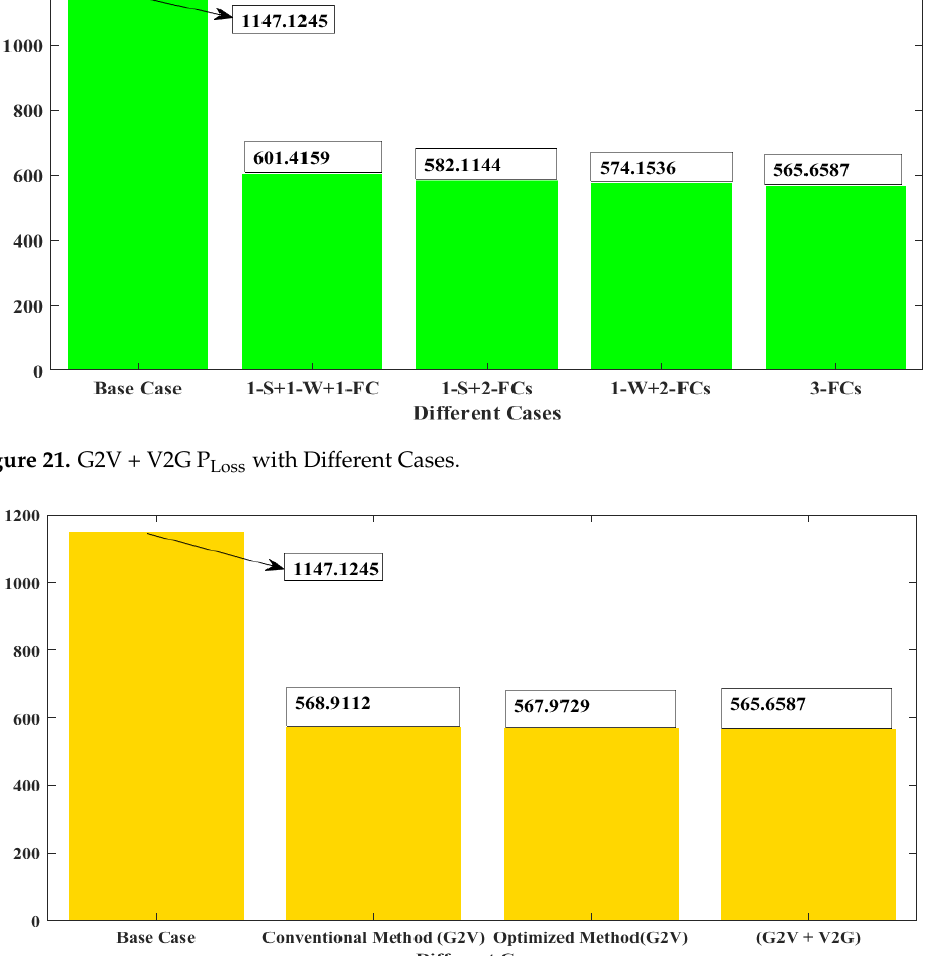
Figure 21. G2V + V2G P Loss with Different Cases.